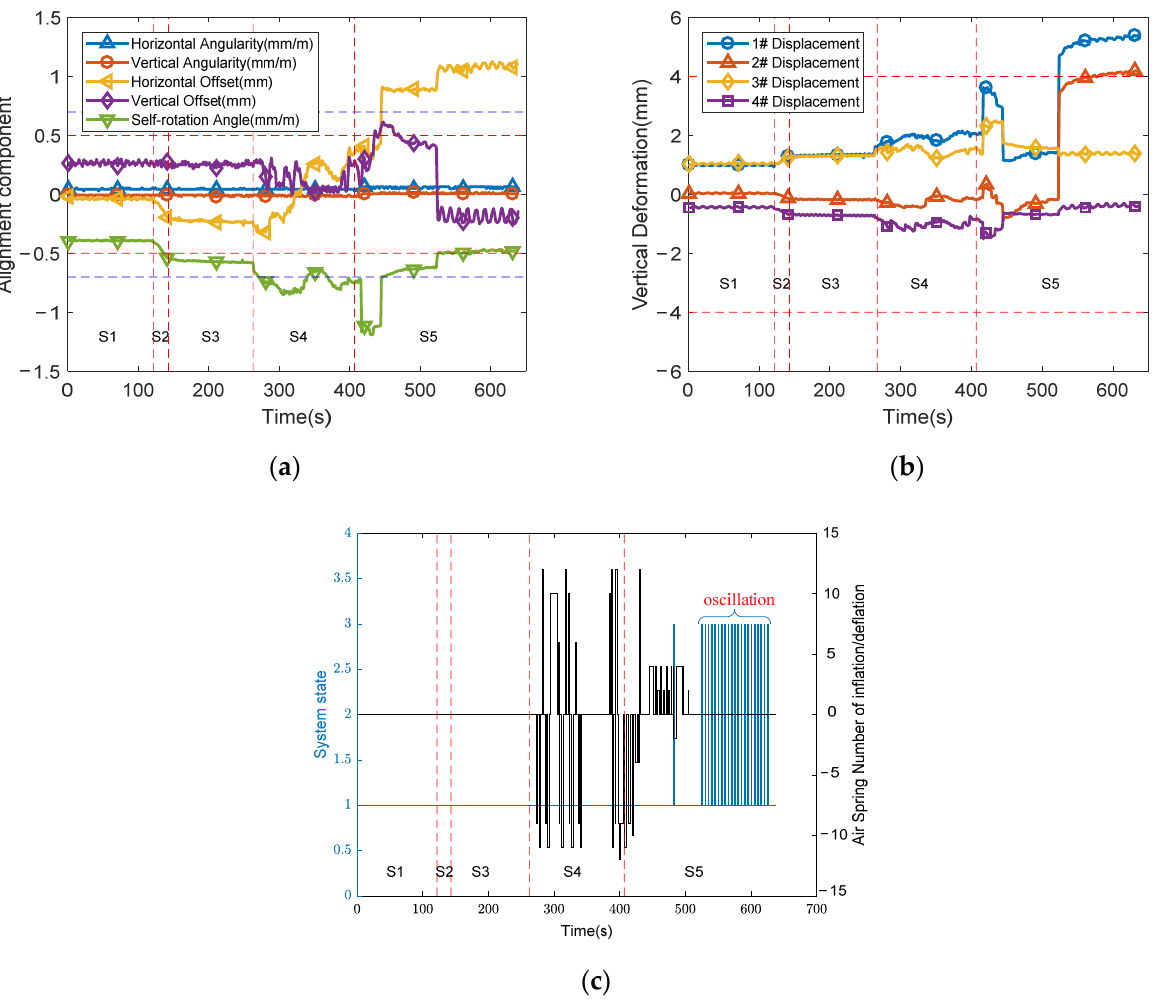
Figure 5. The alignment control process under hard constraints: ( a ) The control process of different alignment components; ( b ) The control process of vertical deformations of air springs at the four corners of the HPDEME-ASVIS; ( c ) The system state and the air spring number of inflation/deflation. It can be seen in Figure